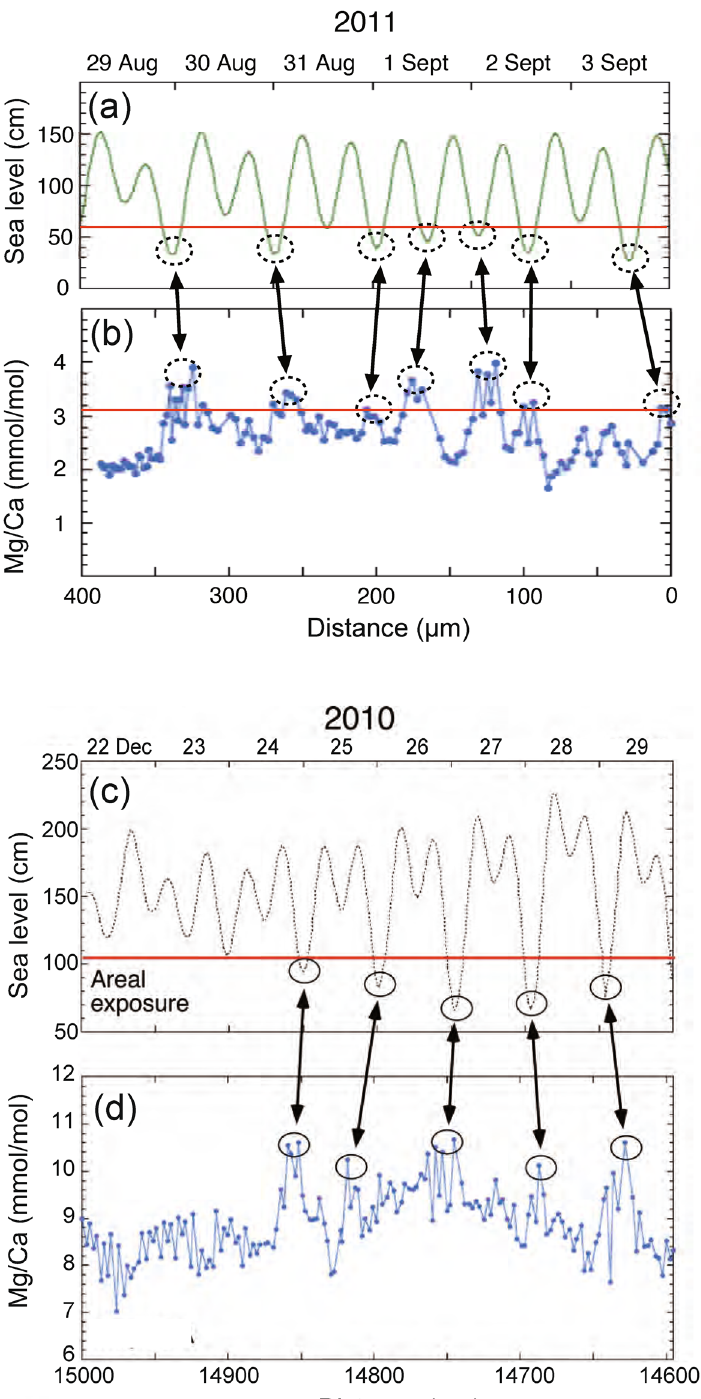
Figure 6. Relationships between sea level change and high resolution Mg/Ca ratio of the specimen A. The profile ( a ) comes from Figure 5c, and the profile ( b ) comes from Figure 2c. The profiles ( c , d ) are from the other measurement site (14.6–15.0 mm) of the specimen A. In both sites, correspondences between Mg/Ca peaks and sea level gouge were